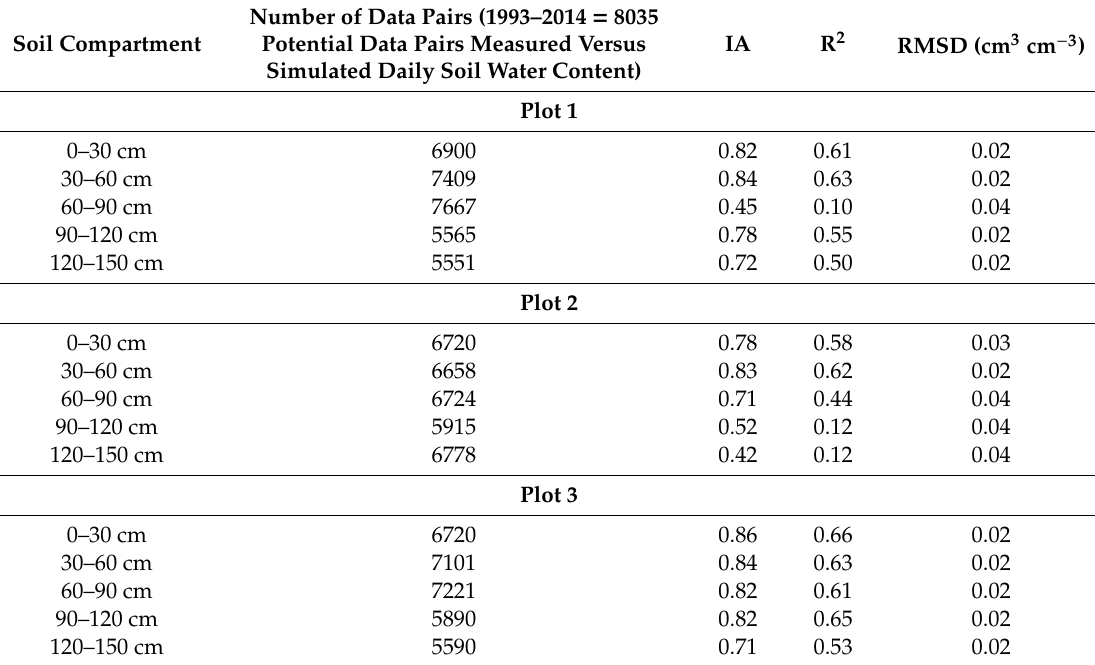
Table 4. Modelling performance for soil water contents.